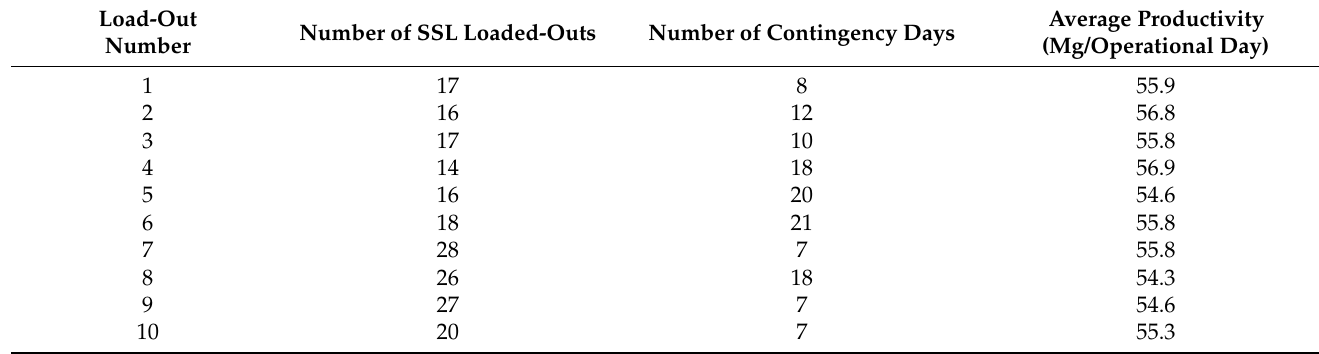
Table 4. Average load-out productivity for 10 load-outs over a 47-week